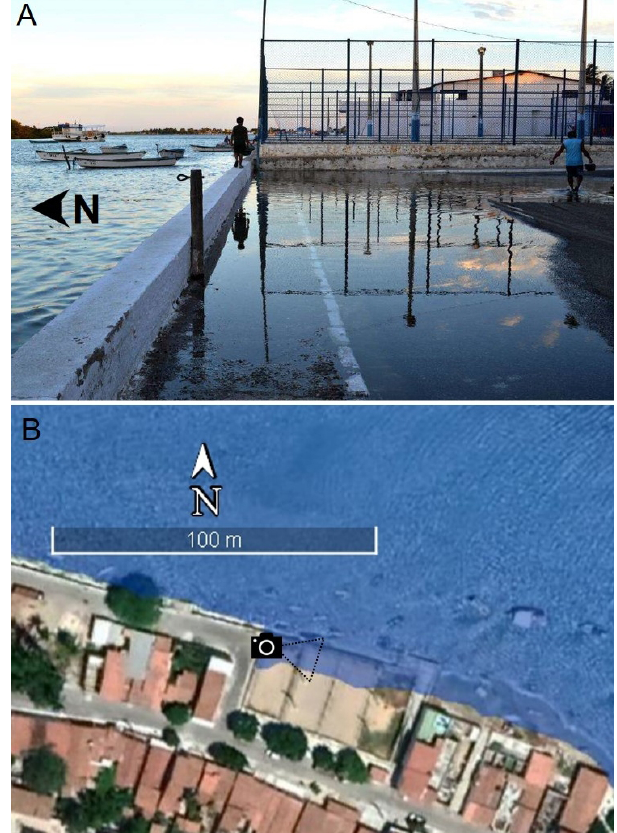
Figure 8. Tidal flooding events on the northern coast of Rio Grande do Norte state: (a) photographic record of Diogo Lopes community, Macau City, on 3 January 2015 (Tiago Ezequiel) and (b) simulated flood event for Diogo Lopes community on 3 January 2015. Ortho- metric height of tidal flood = 1.73m. Basemap from Google Earth Pro: © Google